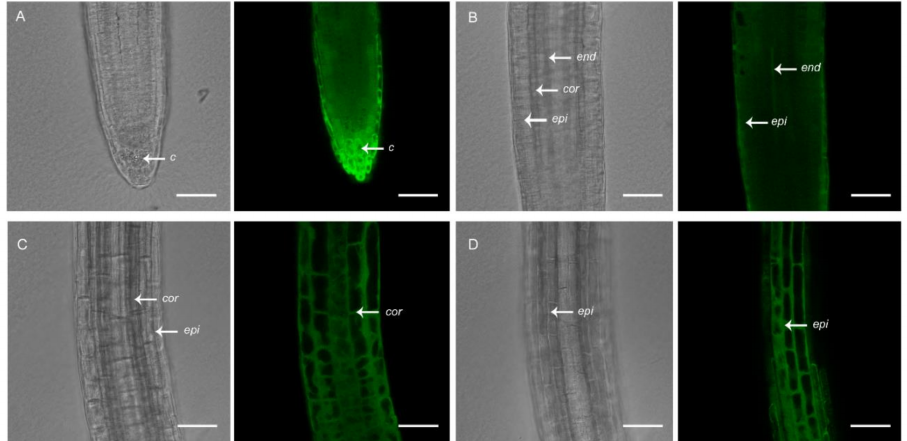
Figure 1. Confocal imaging of primary roots of 5-day-old A. thaliana seedlings expressing UBQ10:GCaMP3 . Representative bright-field and corresponding single-optical section confocal images of the root tip with a focus on the root cap ( A ), meristem ( B ), and elongation zone ( C , D ). c = columella; end = endodermis; epi = epidermis; cor = cortex. Scale bar: 50 µ m.